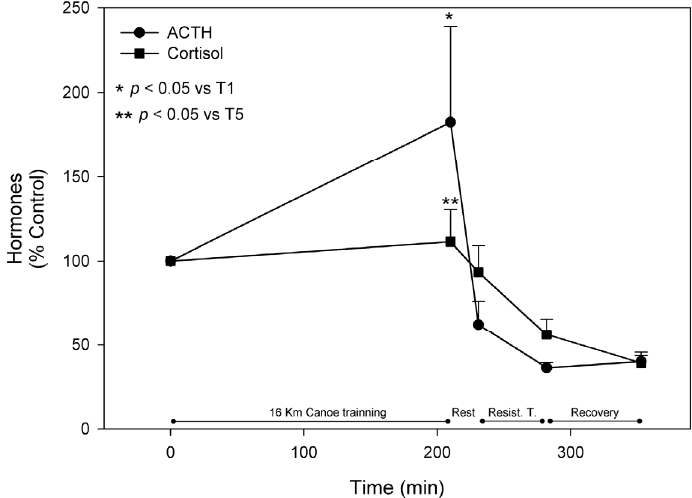
Figure 8. Hypothalamic-pituitary adrenal axis hormones. Adrenocorticotropic hormone (ACTH) and cortisol were measured as described in materials and methods and are represented as mean ± standard error of percentage values against control. * Indicates statistical difference against control values ( p < 0.05). ** Indicates statistical significance when compared to T5 values ( p < 0.05).